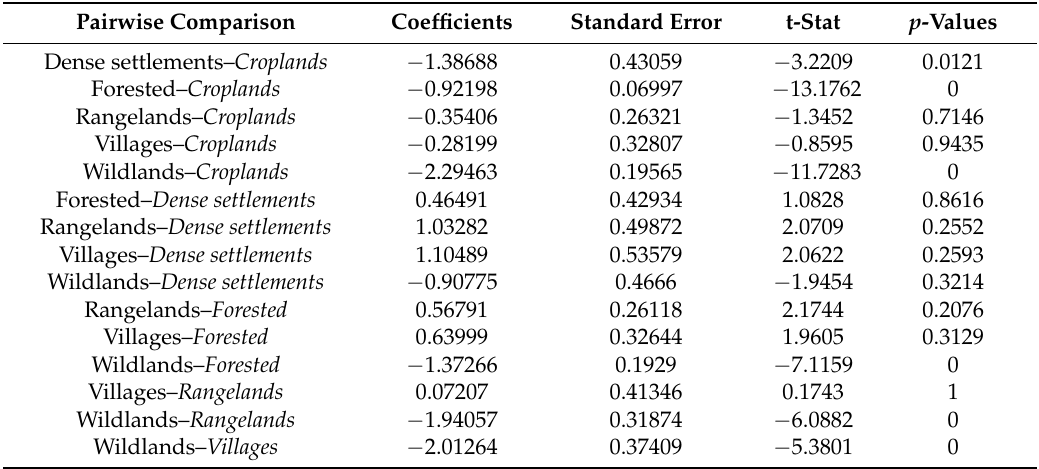
Table 3. Between-anthromes Tukey pairwise comparison for the negative binomial models with fire count and anthromes groups. Note that the reference variable is in italic.